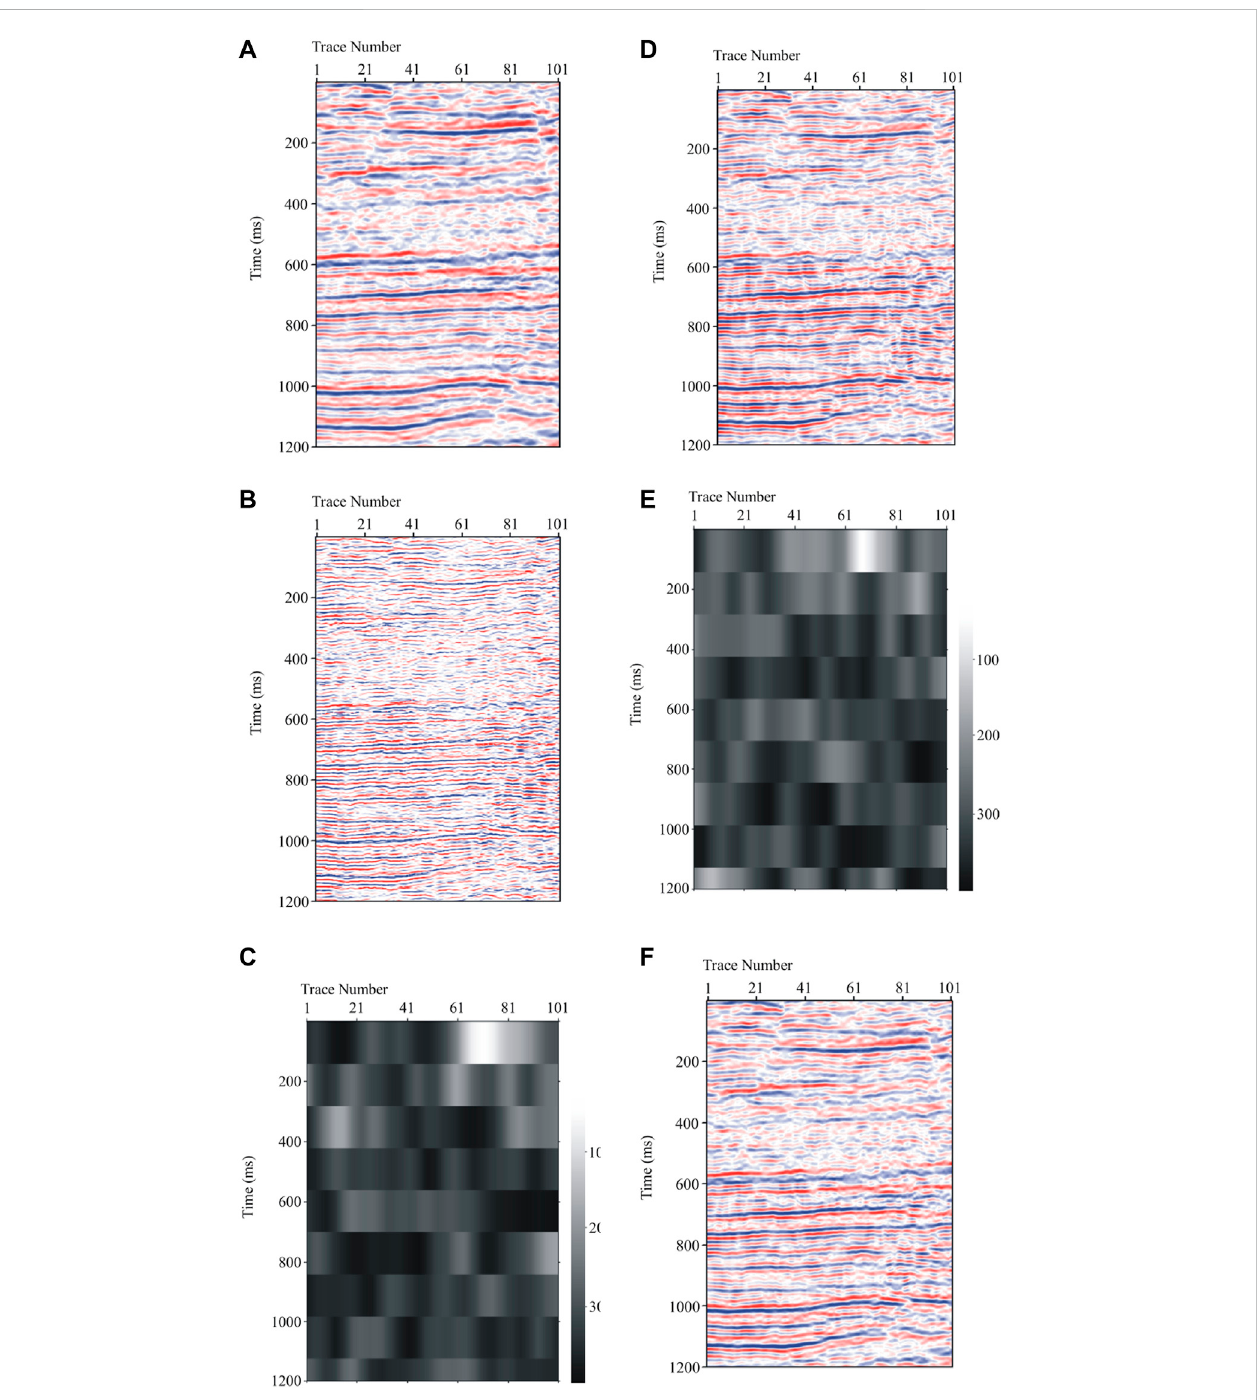
conventional spectral ratio method are shown in Figures 8F, 9F. These resulting seismic sections clearly show improvements in the vertical resolution and more details on stratigraphic features compared to the raw data. Furthermore, it can be seen from these fi gures that the improved resolution using the estimated Q model by the proposed method is better than the one by the